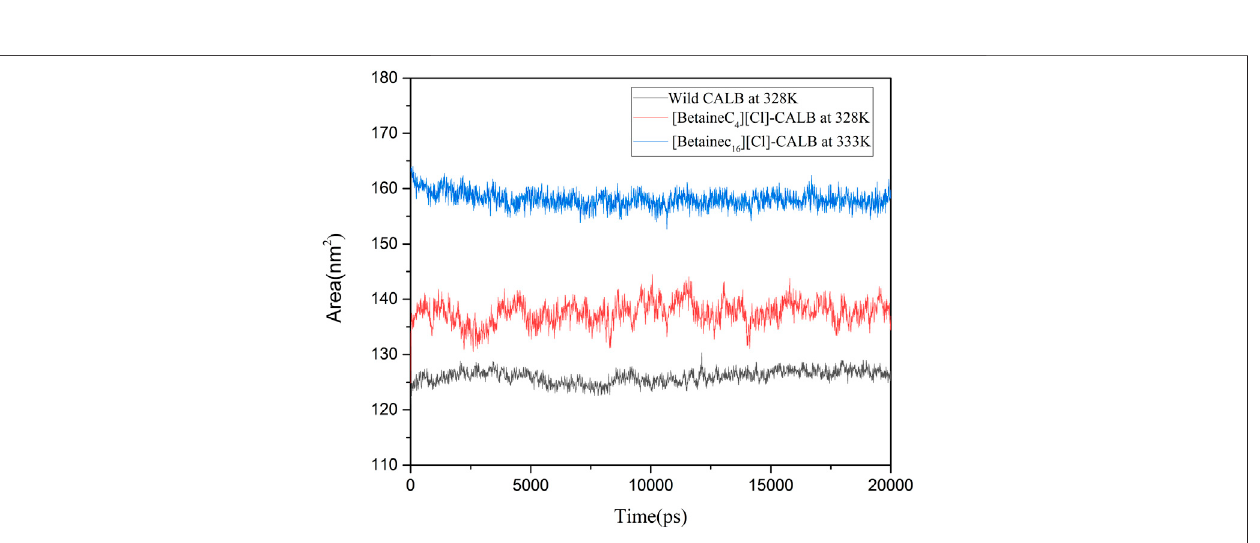
FIGURE 9 | RMSF changes in the native and modi fi ed enzymes at their respective optimal temperatures, using the examples of [BetaineC 4 ][Cl]-CALB and [BetaineC 16